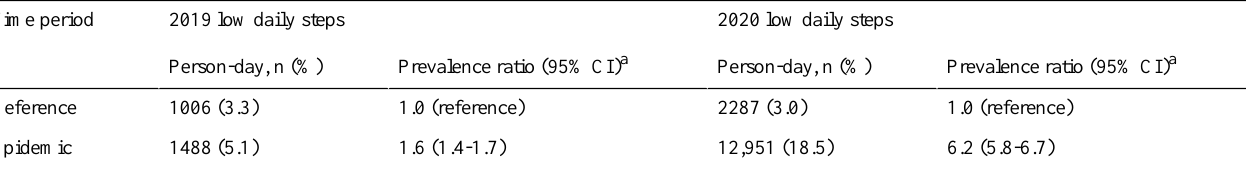
Table 3. Associations of time period with prevalence of low daily steps ( ≤ 1500